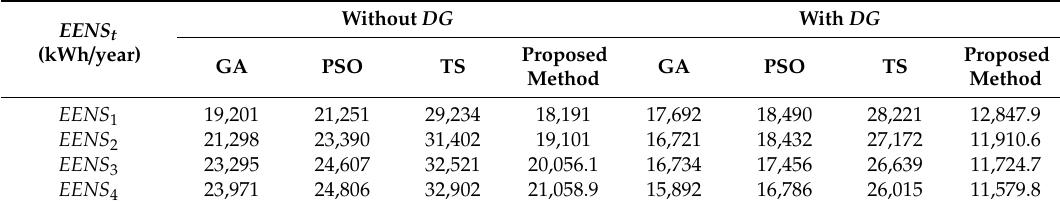
Table 5. The EENS t values for each year of the planning period.